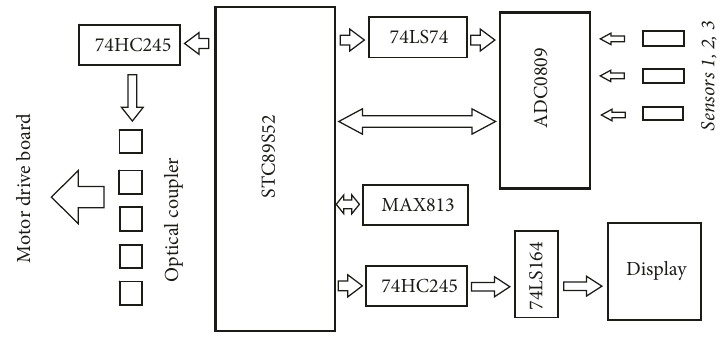
Figure 3: The control board sketch diagram.